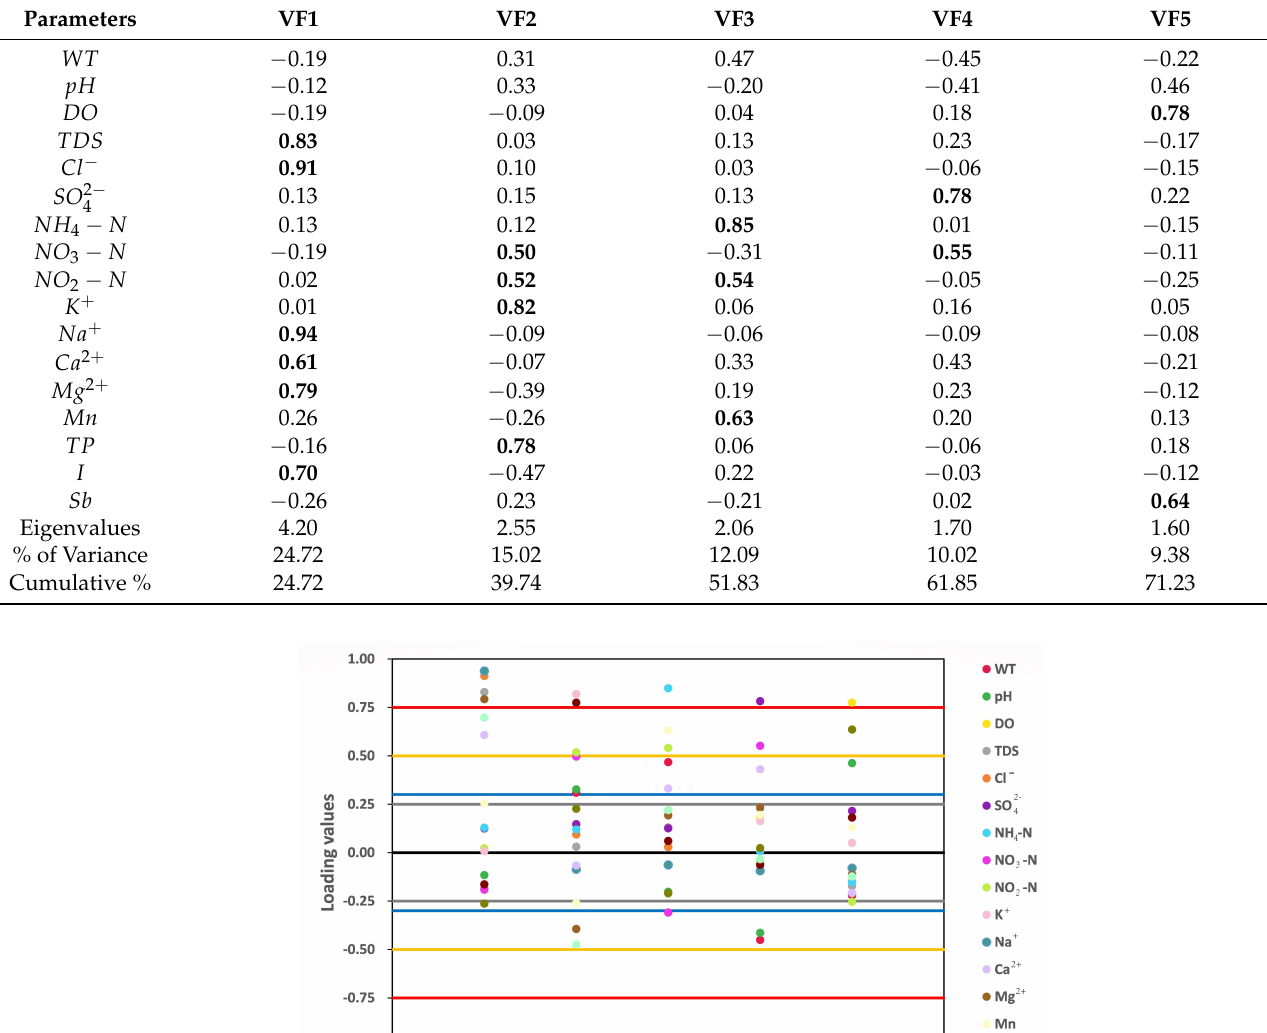
Table 3. The varifactor loadings of 17 parameters after the varimax rotated. Bold values stand for the parameters with medium or strong loadings.